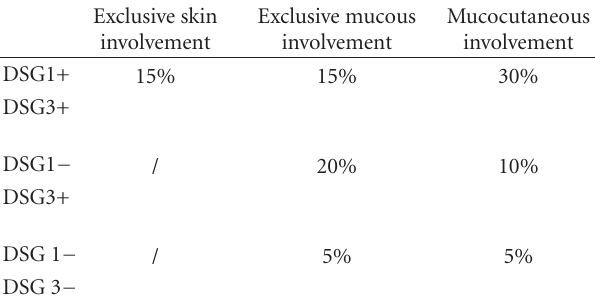
Table 1: Autoantibodies patterns at the time of